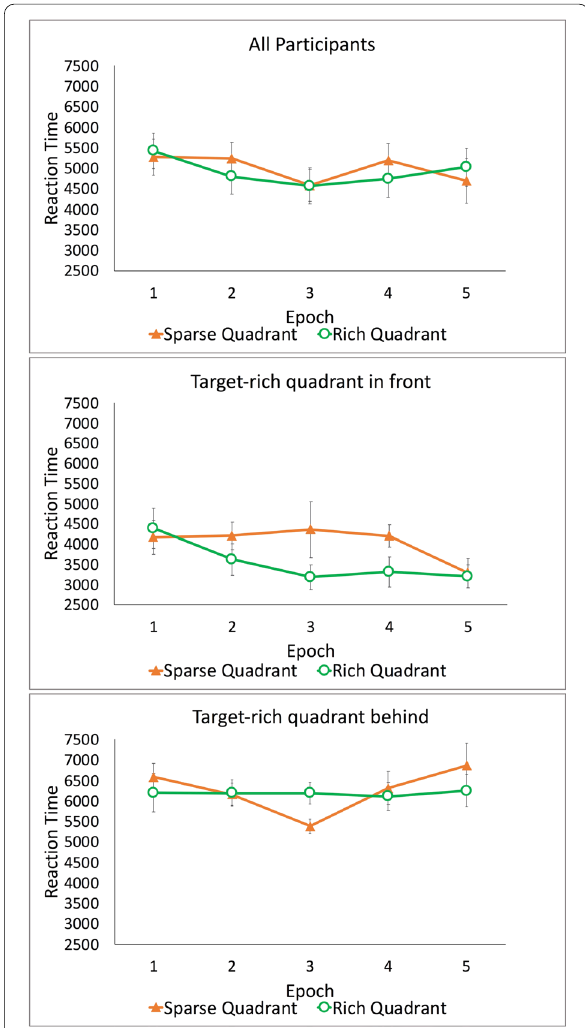
Fig. 2 Average RT across five epochs, presented separately for trials in which the target appeared in the target-rich quadrant and trials in which the target appeared in the direction-matched target-sparse quadrant. Data is presented for all participants (top), then presented separately for participants whose target-rich quadrant was in front of them (middle) and for those whose target-rich quadrant was behind them (bottom). The rich quadrant is classified as the quadrant that the target was most likely to appear in during the training epochs 2–4. For epoch 1, the RT for the quadrant that would later become the rich quadrant is plotted as “rich,” and for epoch 5, the RT for the previously rich quadrant is plotted as “rich.” This allows for tracking of patterns of learning across changes in the probability distribution. Error bars represent 1 standard error of the ±